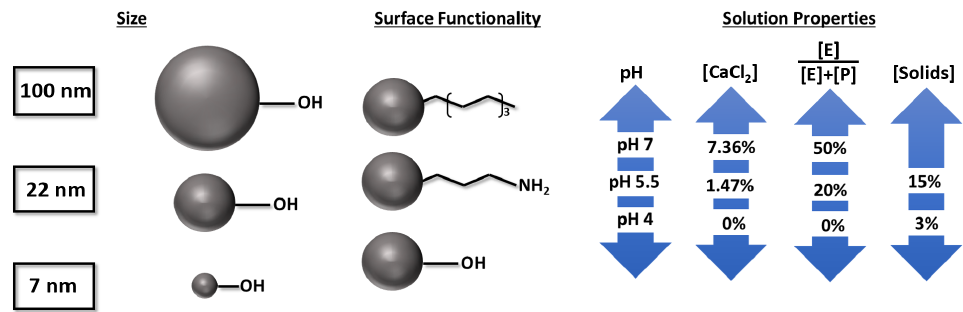
Figure 2. Formulation parameters